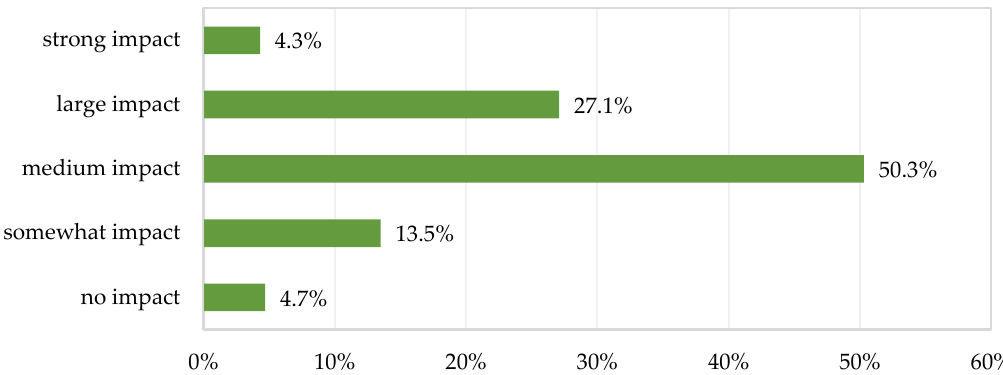
Figure 2. Distribution of the responses regarding the flood impact, the measurement of the flood risk perception.